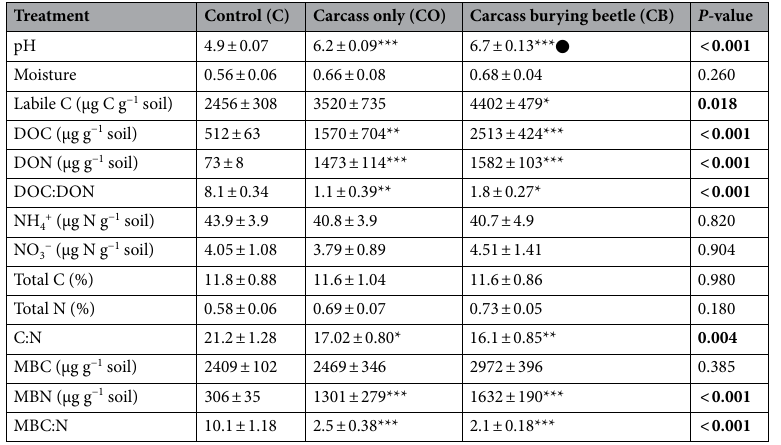
Table 1. Soil characteristics (means ± 1SE; n: C = 8, CO = 8, CB = 8). Effects of treatment were tested with a one-way ANOVA. Treatment level differences were determined by Tukey-pairwise comparisons. * significant